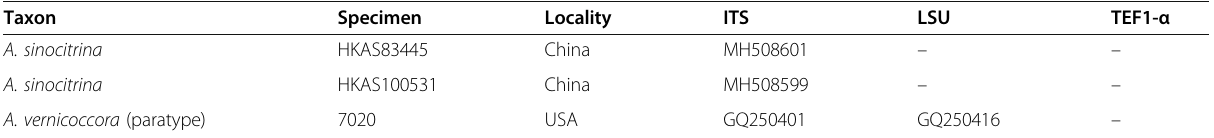
Table 2 Specimens used to identify the mycocecidia of new species of Squamanita in this study are listed with their Herbarium ID and accession numbers. Newly generated sequences are highlighted in boldface (Continued)